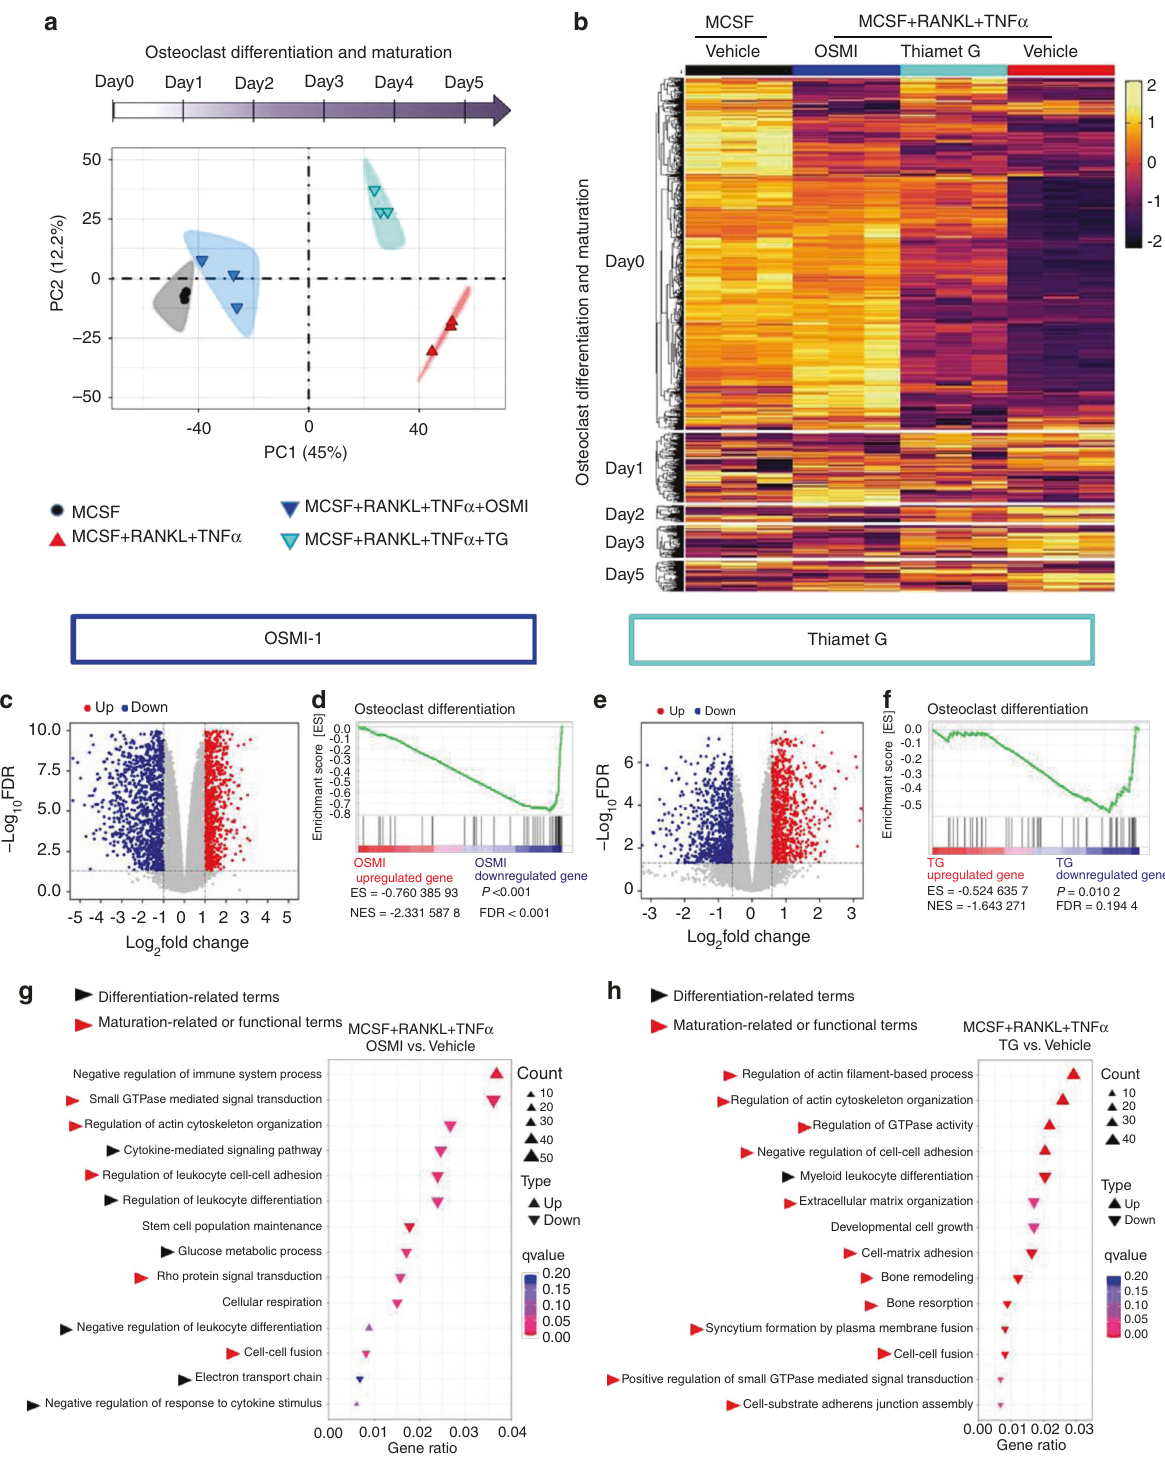
Fig. 6 Differential transcriptomic effects of OGT and OGA inhibition during osteoclastogenesis. RNASeq of osteoclast precursor cells with inhibition of OGT by OSMI-1 or inhibition of OGA by Thiamet-G of osteoclastogenesis with respective controls, n = 3 for each condition. a PCA analysis demonstrating an arrest at different stages by OSMI-1 and Thiamet-G. b Expression heatmap of genes implicated in osteoclastogenesis by integration of publically available transcriptome data from different stages of osteoclastogenesis (GSE138324) 34 . OSMI-1 treatment: c Volcano plot of DEGs. Expression of each gene is plotted as log-fold change of expression ratio with respect to controls; upregulated and downregulated genes are represented by red and green dots, respectively. d GSEA enrichment plot for osteoclast differentiation. g Geneset functional analysis plots of signi fi cantly enriched Gene Ontology (GO) biological processes related to osteoclastogenesis. Upward and downward triangles indicate the processes enriched in up- and down-regulated genes, respectively. Thiamet-G treatment: e Volcano plot of DEGs. f GSEA enrichment plot for osteoclast differentiation. h Geneset functional analysis plots of the signi fi cantly enriched GO biological processes related to